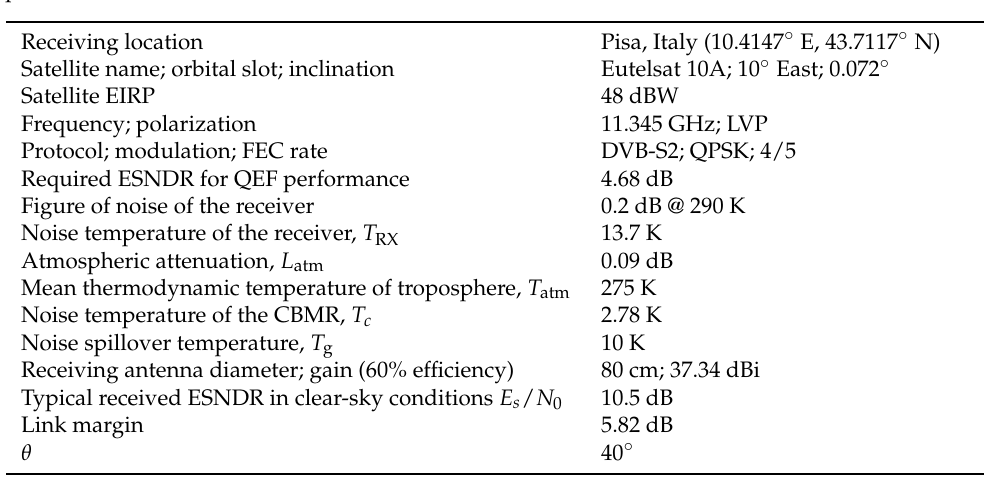
Table 3. Parameters of a DTH TV broadcast satellite downlink [8]. LVP: linear vertical polarization. QPSK: quadrature phase shift keying. DVB-S2: digital video broadcasting via satellite, 2nd generation.